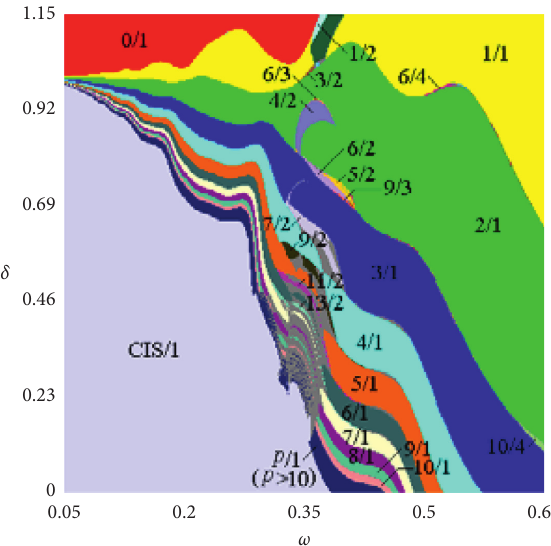
Figure 4: Local enlargement of Figure 2(b).